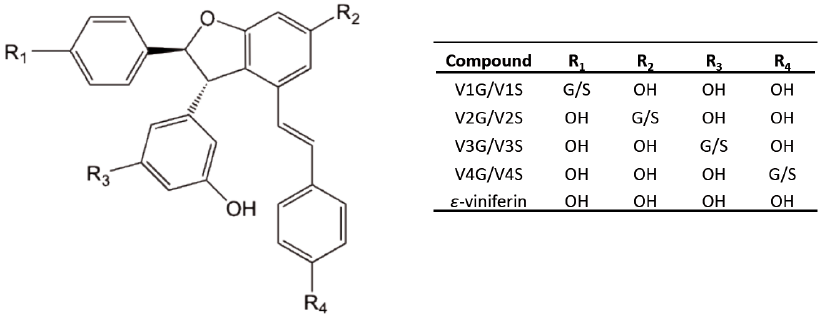
Figure 1. Structural representation of ε -viniferin and its glucuronide and sulphate metabolites. G: glucuronic acid, S: sulphate, OH: hydroxy